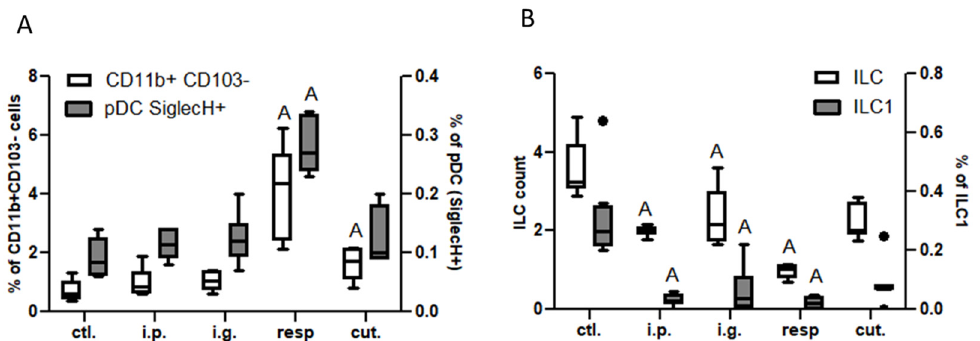
Figure 5. Dendritic cells and ILC in lung tissue: ( A ) CD11b + CD103 − DC subtypes (empty bars) and pDC (gray bars) in the different groups of exposed mice. DC were defined as CD45 + CMHII + CD11c + cells and DC subtypes were defined based on CD11b and CD103 expression. pDC were defined as SiglecH + cells within CD11b − CD103 − cells. ( B ) ILC counts (CD45 + Lin − CD4 − CD127 + cells, empty bars) and ILC1 frequencies (ST2 − NK1.1 + cells within ILC, gray bars) in the different group of mice. All frequencies are expressed using CD45 + cells as a reference. “A” indicates a significant difference with ctl. group ( p < 0.05 using non-parametric Kruskal–Wallis and Dunn’s post-test). Bold black dots represent outliers.